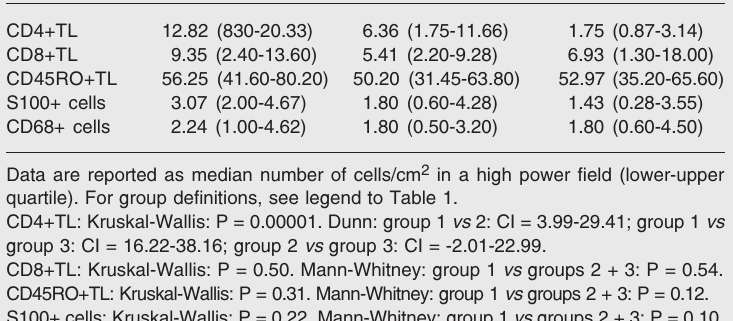
Table 4. Characteristics of the cell populations in the duodenal mucosa. Variable